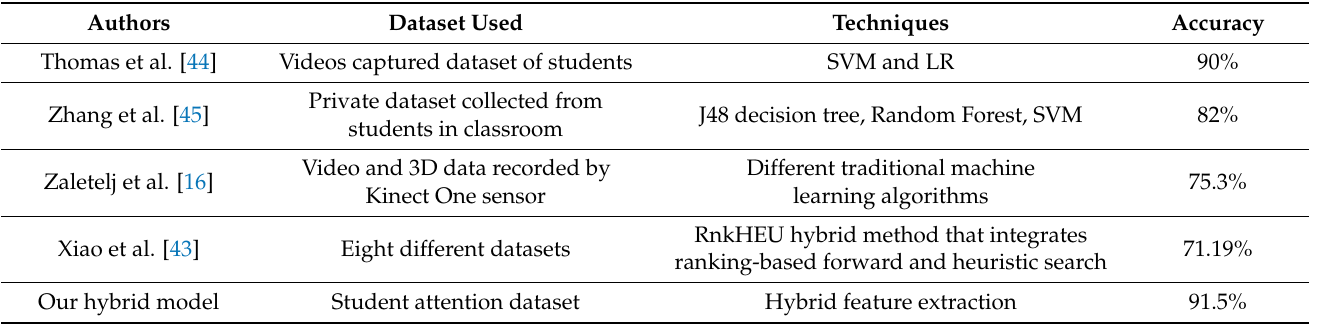
Table 6. Performance comparison of our model with previous studies.